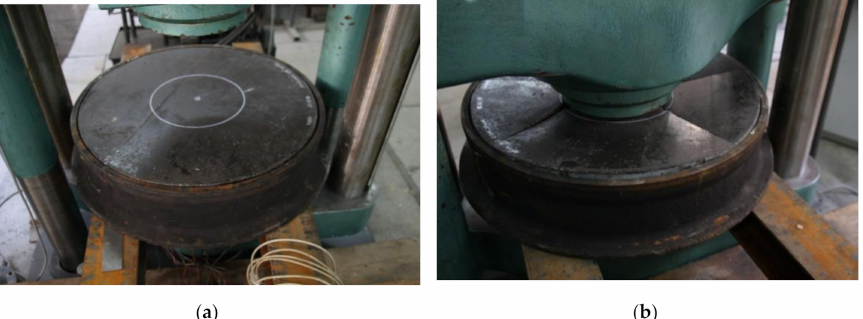
Figure 9. Laboratory test setup of a vinyl ester polymer concrete manhole cover [27], ( a ) before loading, ( b ) after